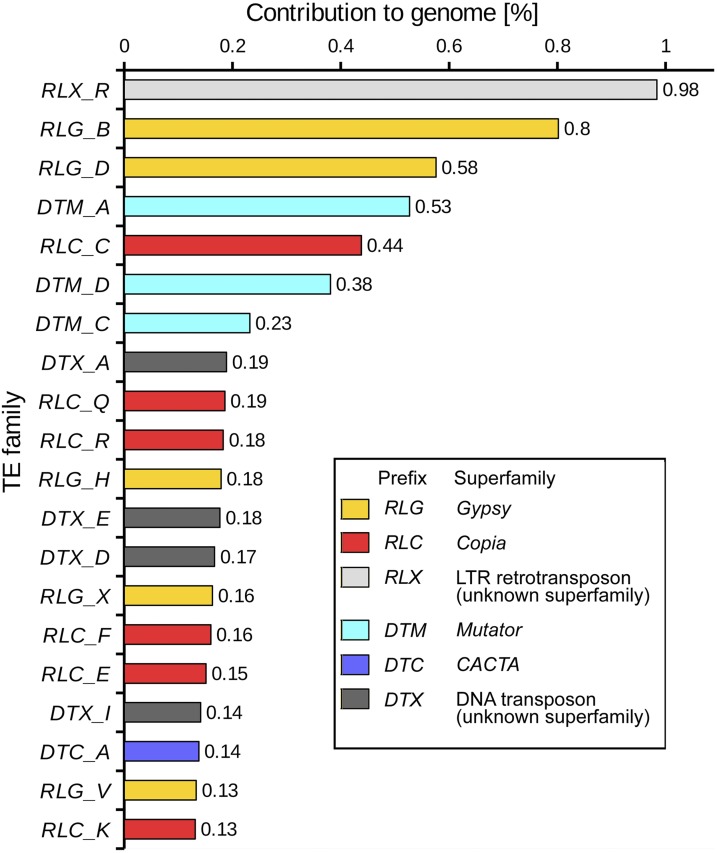
Contributions of the 20 most abundant transposable element (TE) families to the whole genome. Fifteen families could be assigned to four different superfamilies (see inset), the remaining did not contain coding sequences (e.g., transposase), which would have allowed their classification into known superfamilies.